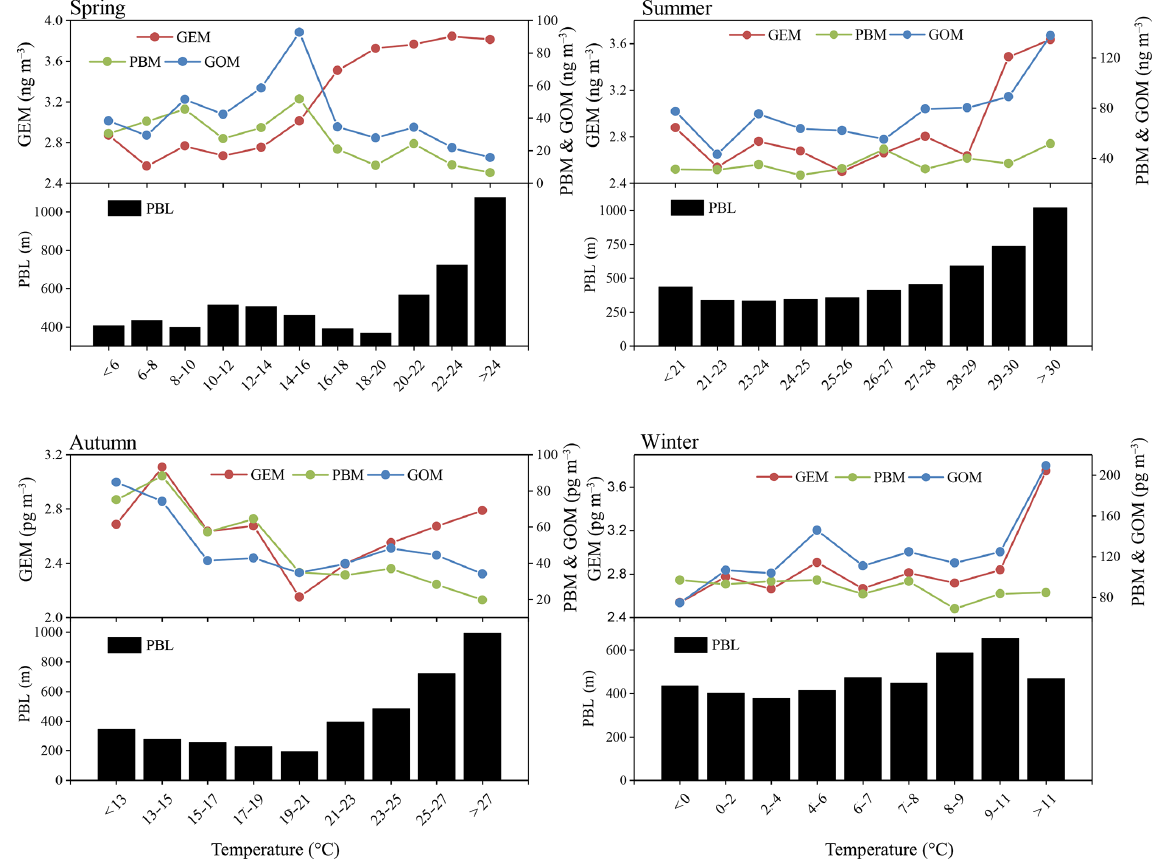
Figure 6. The variation in atmospheric Hg (GEM, PBM, and GOM) and PBL as a function of temperature in all four